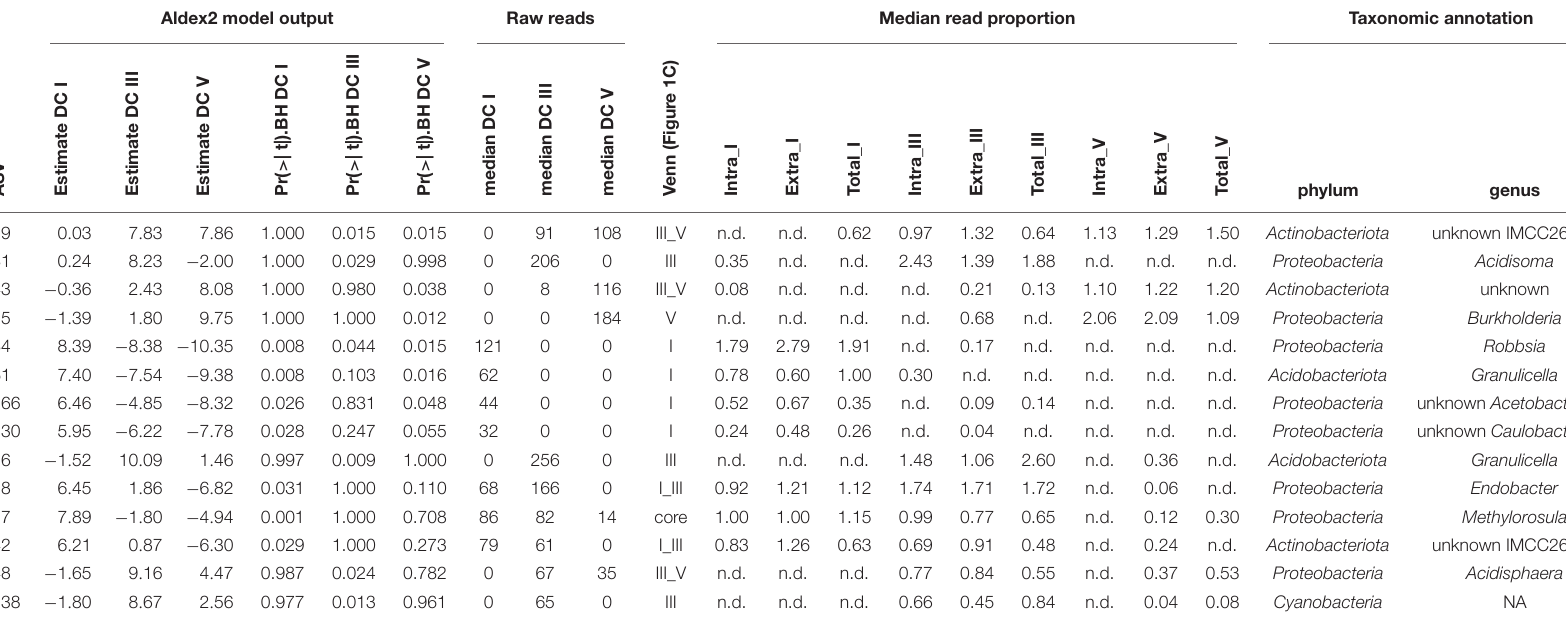
The output of Supplementary Table 1 was reduced to only ASVs that were not contained in the core ASVs of the different DCls ( Figure 4A ). For each of those ASVs, the Aldex2 estimate and Bonferroni-Holm corrected p-value of the Aldex2 model was reported. The median read number was indicated in order to show the size of the ASV. Their location in the overall Venn diagram was also shown. This can be interpreted as their respective center of mass. The median read proportion for each sample group was displayed to reflect in which group and to which extent these ASVs have been detected. n.d. = not